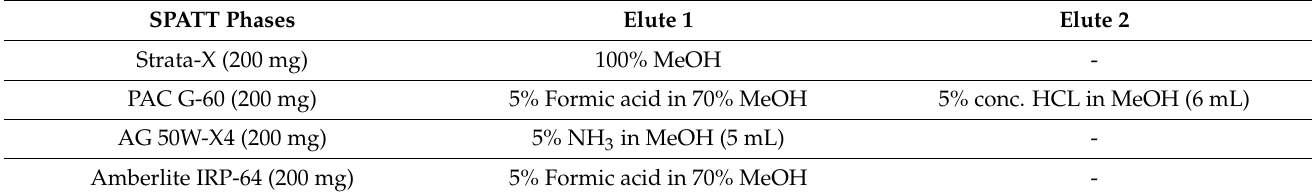
Table 4. Extraction steps for modified resins